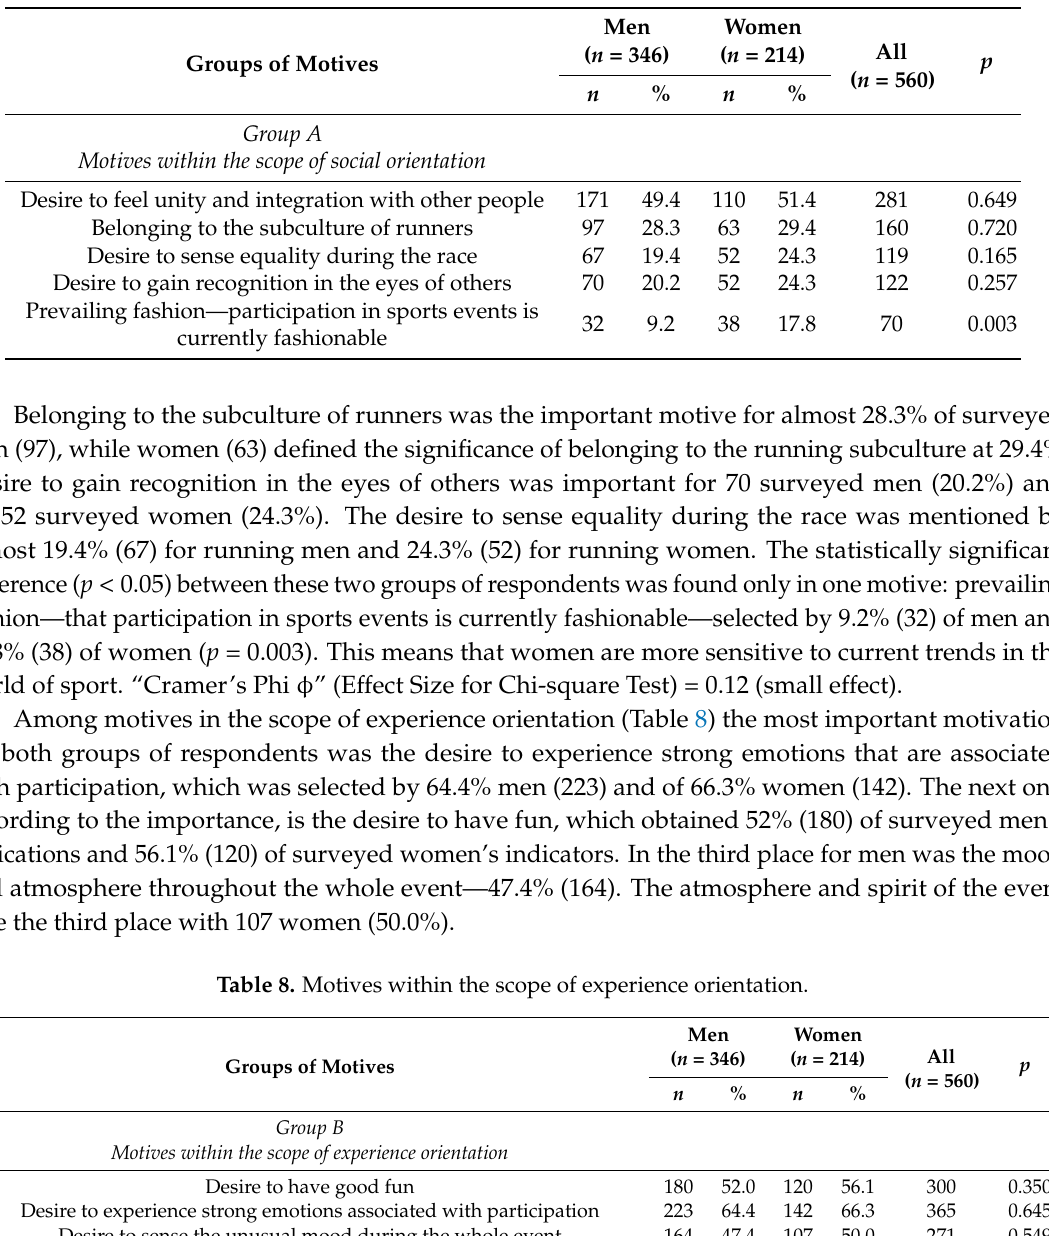
Table 7. Motives within the scope of social orientation.